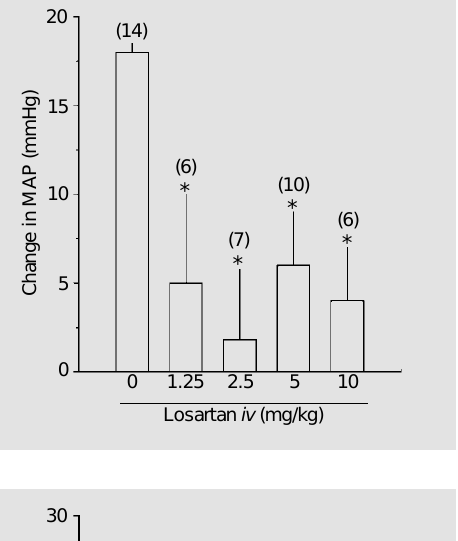
Figure 2. Effect of intravenous injection of captopril on the pres- sor response to icv losartan (90 µg). N = 7 for each group. *P<0.05 vs doze zero (Student- Newman-Keuls test). MAP = mean arterial pressure.